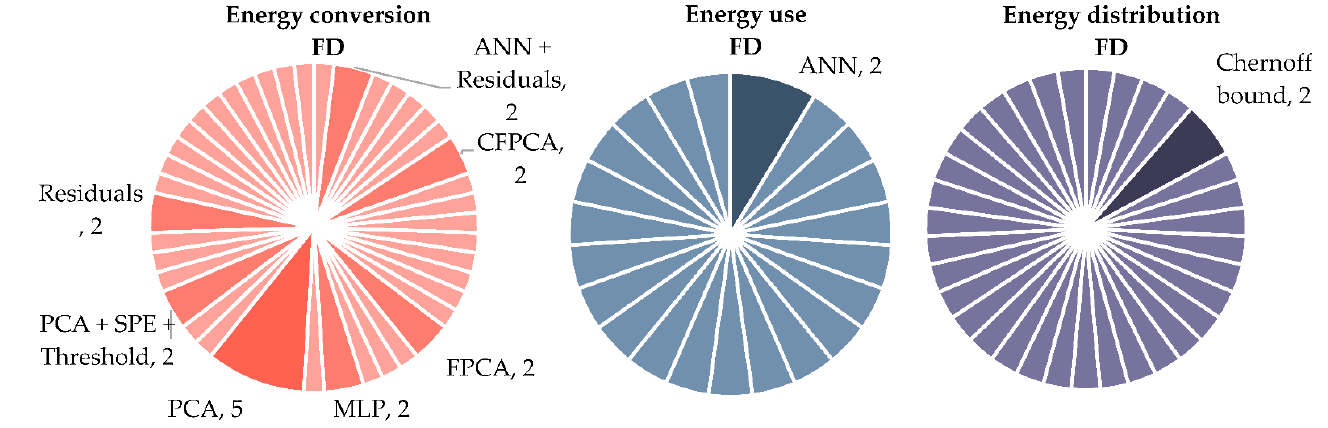
Figure 12. Energy-conversion, energy-distribution, and energy-use EST groups for FD.